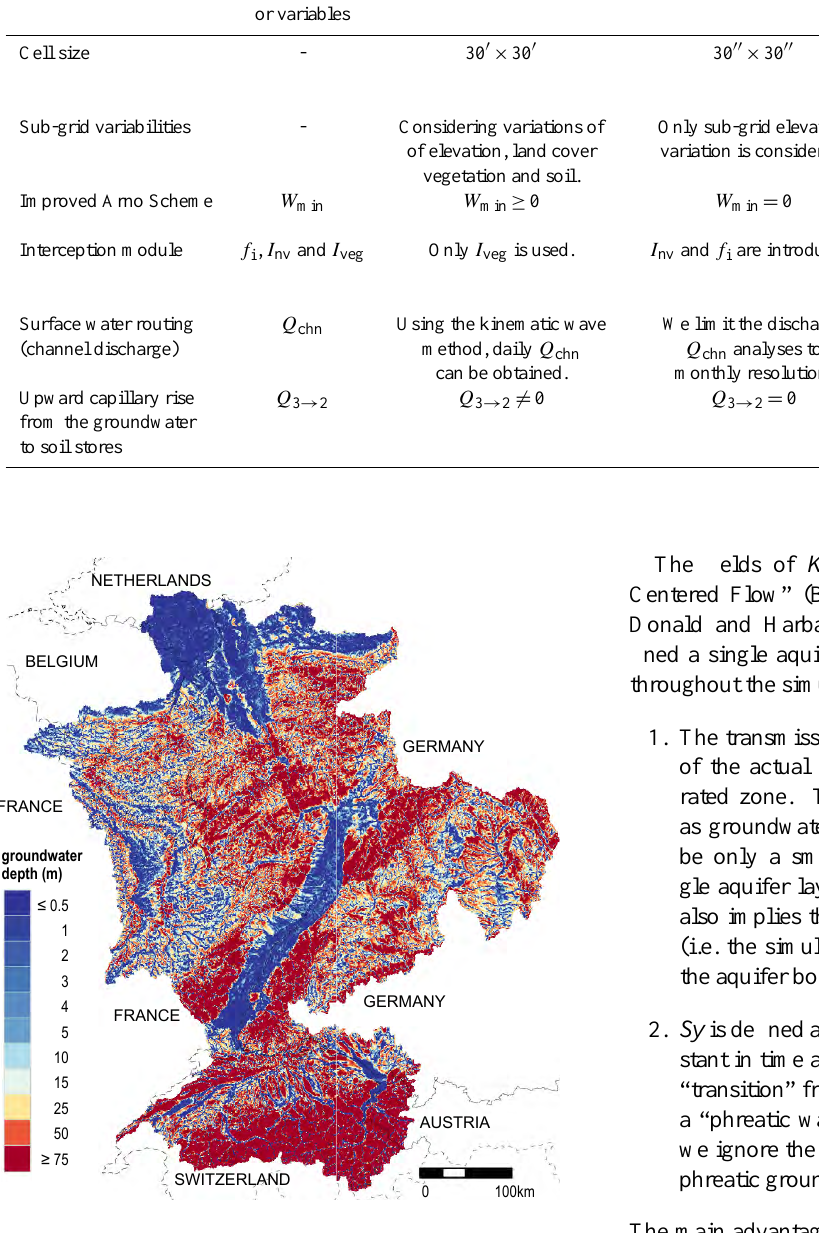
Fig. 3. The approximate steady-state groundwater depth map that is used for aquifer classification. Here, we classified cells that have groundwater depth below 25m and their downstream cells as the “sedimentary basin”, where shallow productive aquifer pockets are usually located. Moreover, we also made sure that a sedimen- tary basin cell must have at least one neighboring cell in its left, right, upper, or lower extents. The remaining cells were classi- fied as “mountainous areas”, where groundwater depths are large (see Sect.